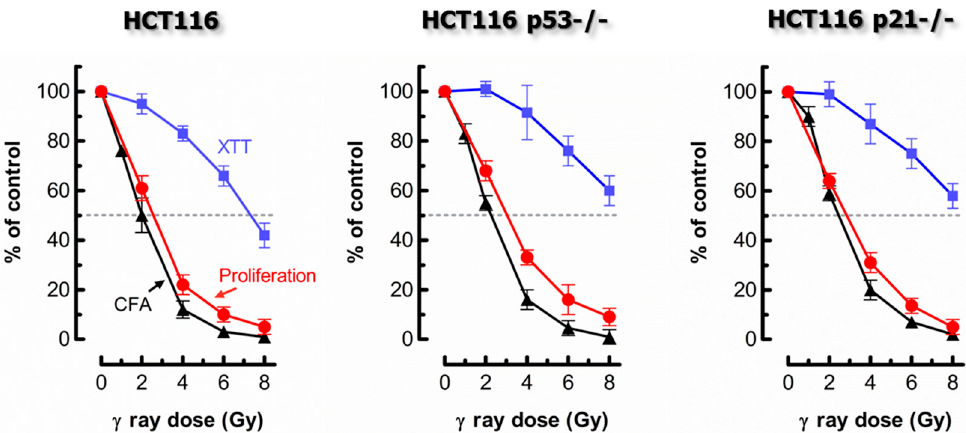
Figure 2. Comparing the responses of the HCT116 parental cell line and its p53 knockout (HCT116p53 − / − ) and p21 knockout (HCT116p21 − / − ) derivatives to ionizing radiation. Radiosensitivity was measured by the proliferation (cell counting) (red circles), colony formation (black triangles), and 96-well plate XTT colorimetric (blue squares) assays. The results were generated by exposing cells to radiation followed by incubation in fresh medium for 3 days (proliferation; XTT) or 10 days (colony formation). Bars, standard error (SE); CFA, colony forming ability. XTT, 2,3-bis-(2-methoxy-4-nitro-5-sulfophenyl)-2H-tetrazolium-5-carboxanilid). Data obtained from Mirzayans et al. [3,4].